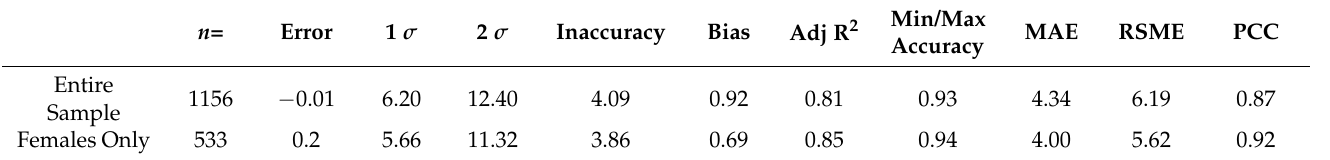
Table 5. TCM model